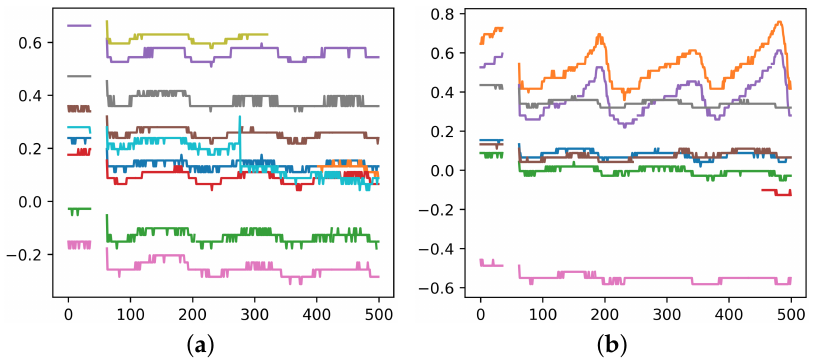
Figure 2. Waveforms of ONU’s optical power. The vertical axis represents the optical power. The horizontal axis represents the sampling point, which is sampled every 10 min. Each subplot shows the situation of one secondary splitter, and curves of different colors reflect the waveforms of different ONUs under the same secondary splitter. Similarity of two waveforms indicates that the two ONUs are suffering the same perturbation. ( a ) Ideal perturbation. ( b ) Non-ideal